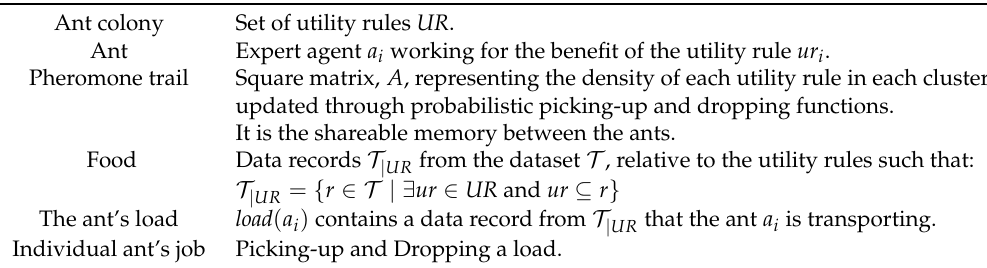
Table 2. Ant colony